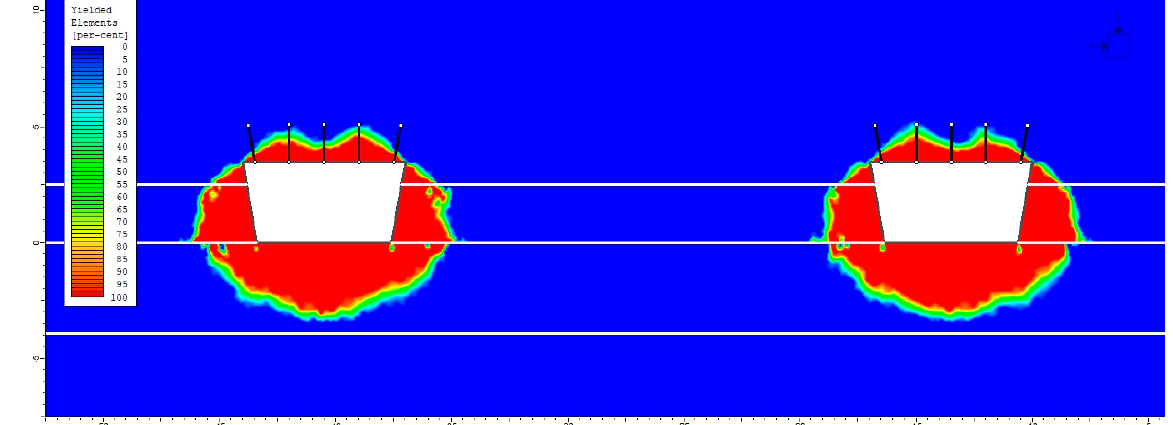
Figure 5. Yielded element area around heading – 1 and heading – 2, load variant – 1.